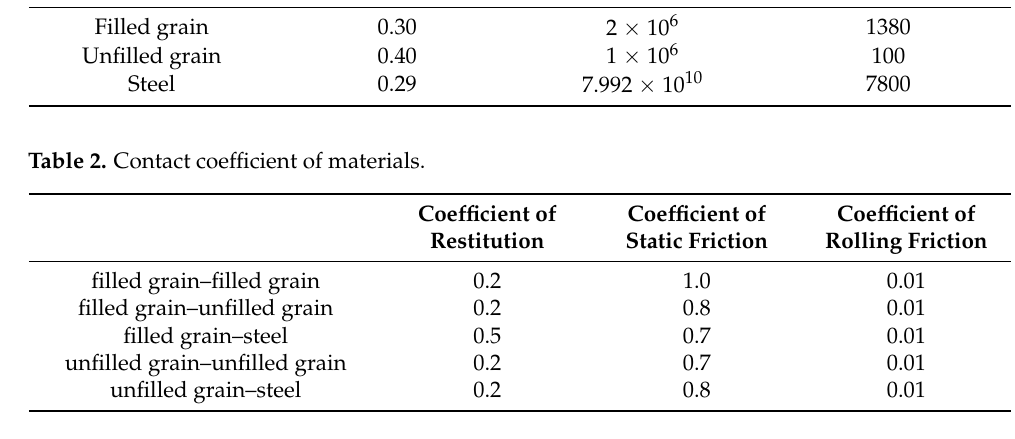
Table 1. Physical parameters of materials.